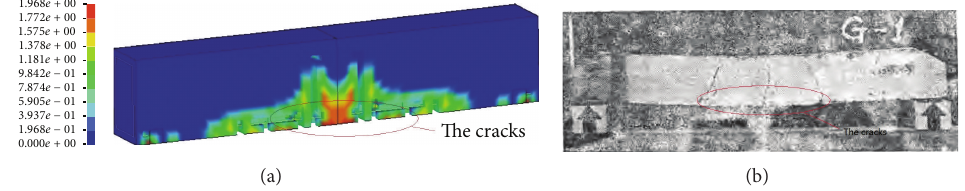
Figure 4: Comparison between FE model (a) and experimental model (b) of structures.